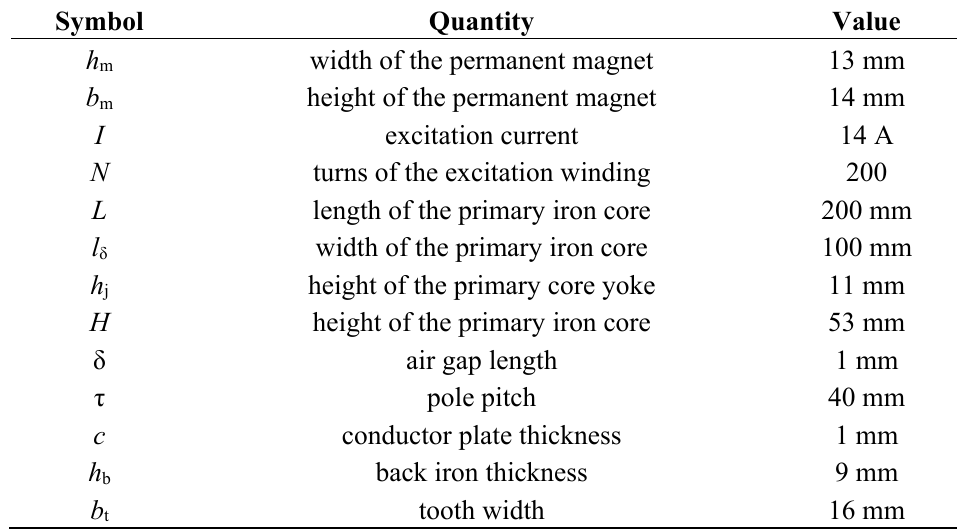
Figure 19. ( a ) Prototype of the hybrid excitation linear eddy current brake and ( b ) the test bed. The final parameters of the hybrid excitation linear eddy current brake are shown in Table 2. Table 2. Final parameter of the hybrid excitation linear eddy current